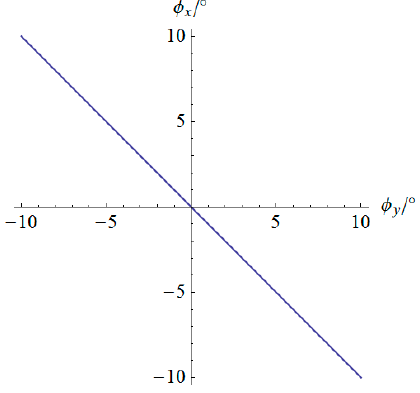
Figure 4. Angular displacement of the mobile platform.